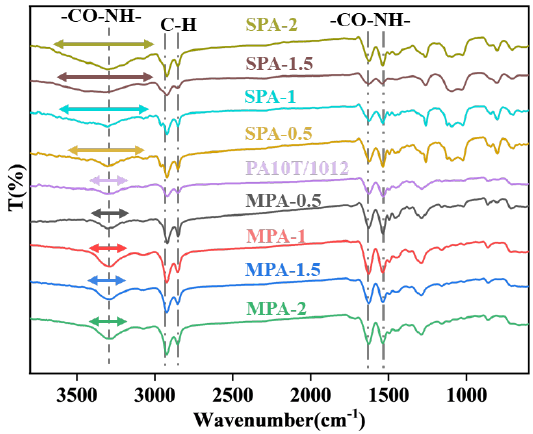
Figure 4. FTIR spectra of MPA composites and SPA